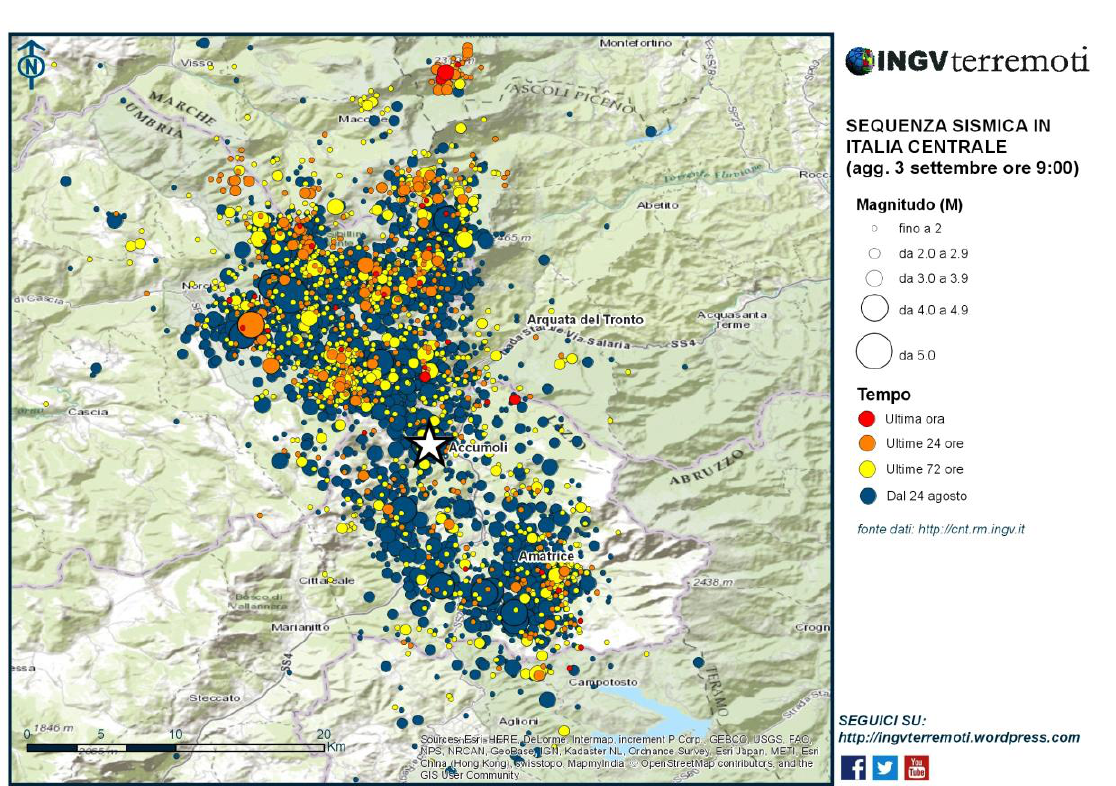
Figure 1: Map showing the spatial and temporal evolution of the seismic sequence published September 3, 2016 on the INGVterremoti blog. Red: last hour; orange: last 24 hours; yellow: last 72 hours; blue previous earthquakes (since August 24 th